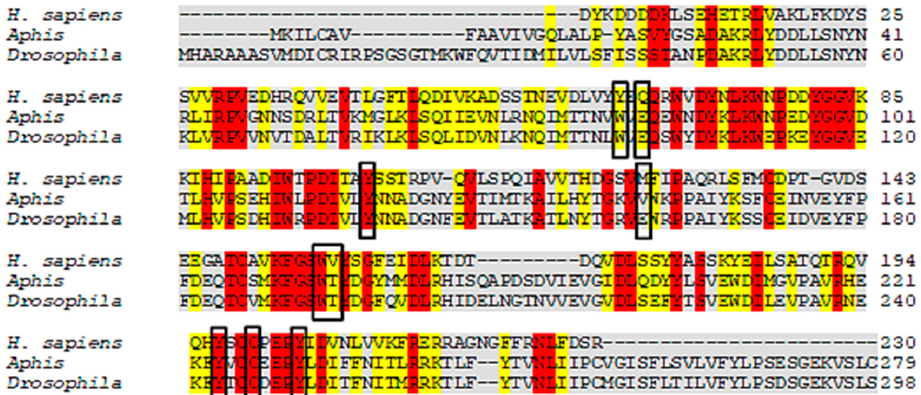
Figure 3. Alignment of H. sapiens , A. gossypii, and D. melanogaster nicotinic acetylcholine receptors (nAChRs) protein sequences. The gray regions represent non-similar and non-identical amino acids. The red regions represent identical amino acids. The yellow regions represent similar amino acids. The black boxes represent conserved regions of the active site which bind to the inhibitor.